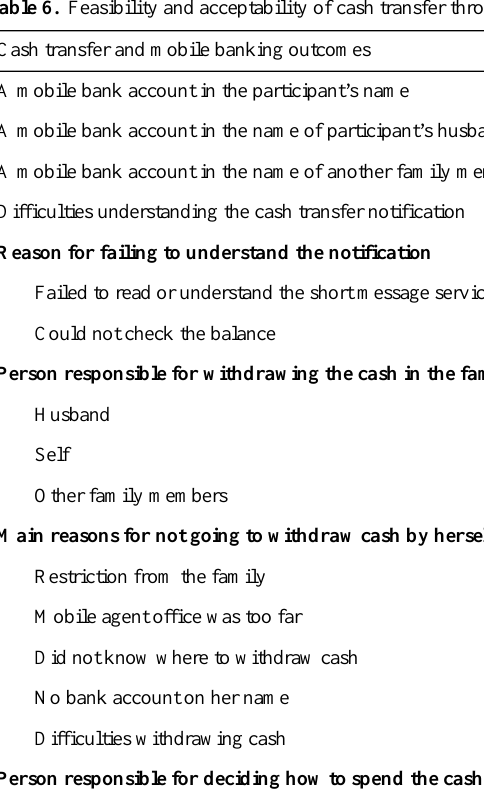
Table 6. Feasibility and acceptability of cash transfer through mobile banking from the end of study survey (n=275).